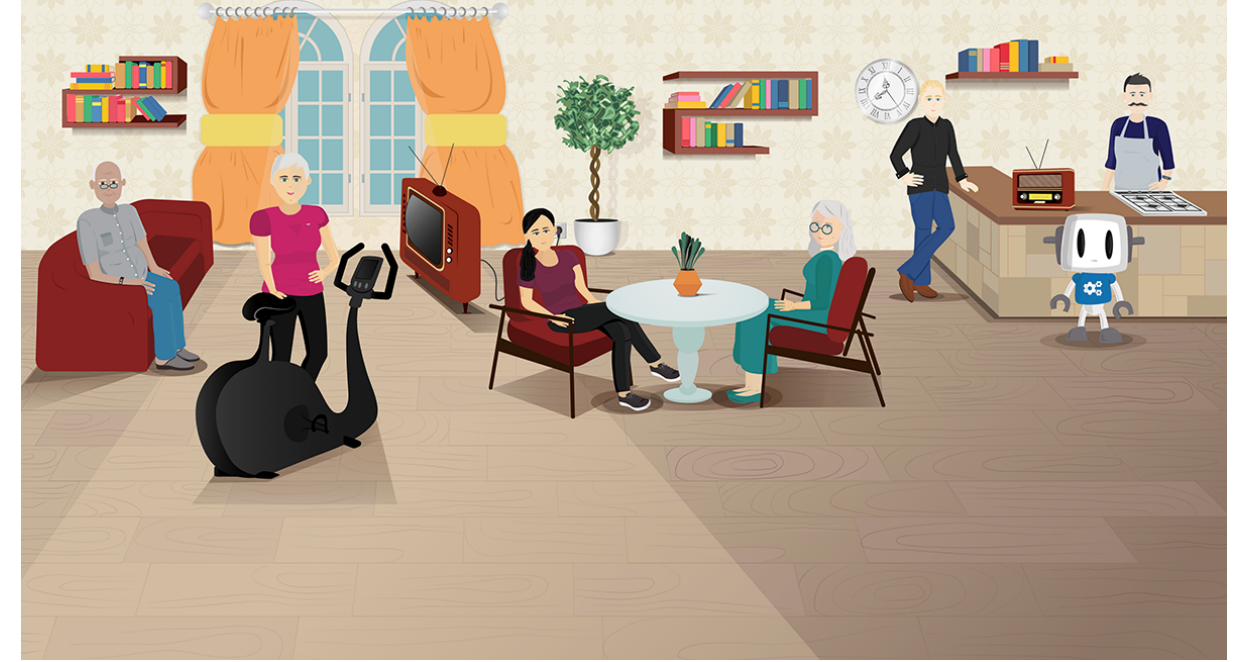
Figure 2. Screenshot of the current test version of the Council of Coaches web application with the chronic pain coach, without a dialogue box